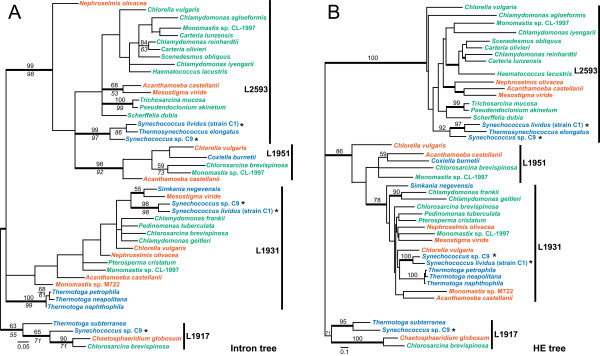
Phylogenetic relationships of rDNA group I introns (A) and their LAGLIDADG HE proteins (B). (A) The 50% majority-rule consensus tree inferred using Bayesian analysis under the GTR + I + Γ substitution model. The tree includes only those LAGLIDADG HEG-containing group I introns that are inserted at the same four rDNA positions (Table 1) at which introns are found in bacteria. The tree is arbitrarily rooted on the branch leading to the L1917 introns. The thick branches denote ≥ 0.95 posterior probability for groups to the right of the values. Numbers above branches indicate minimum evolution (Jukes-Cantor model) bootstrap (BS) values from 2000 replicates, and numbers below branches indicate maximum parsimony values from 200 replicates. Bootstrap support values < 50% are not shown. Vertical bars on the right of the tree mark groups that share insertion positions in the LSU rDNA. Bacterial introns are in blue, chloroplast introns are in green (these are all from green algae), and mitochondrial introns are in vermillion (these are all from green algae, except for the three introns from the amoeba Acanthamoeba). Taxa labeled with an asterisk possess the novel introns presented in this paper. The scale bar indicates the inferred number of substitutions per site. (B) Minimum evolution phylogenetic tree of the HE proteins, analyzed under the WAG + Γ substitution model. The tree is arbitrarily rooted on the branch leading to the L1917 HEs. Numbers above the branches indicate the bootstrap support value (from 500 replicates) from a neighbor-joining analysis using the JTT substitution model. Other features of labeling are as in A.